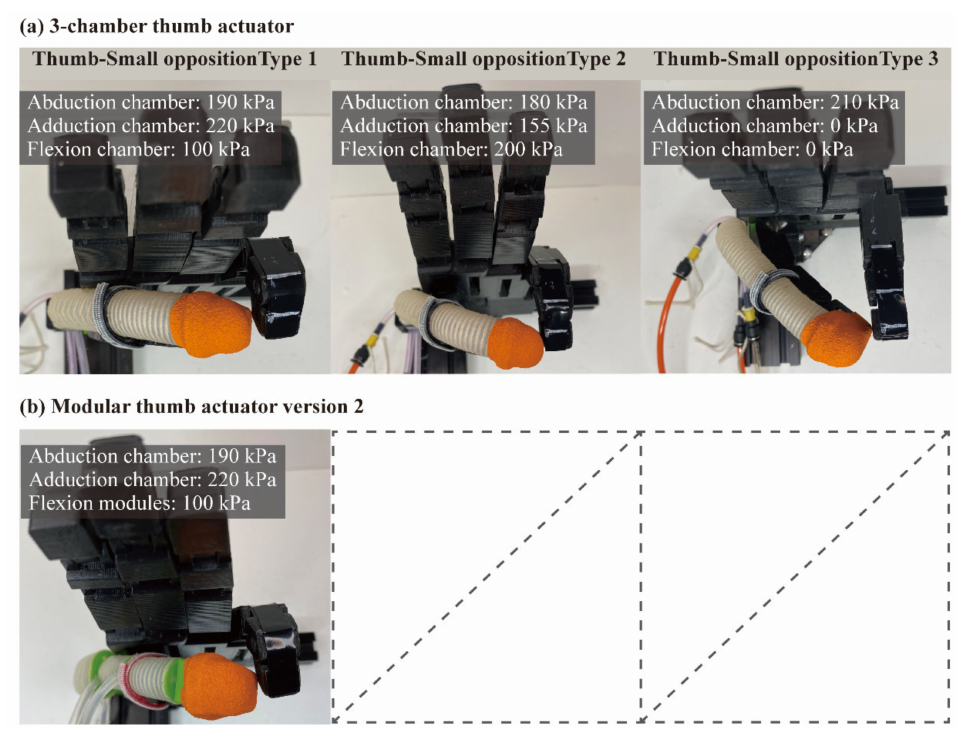
Figure 8. Three types of thumb–small opposition.